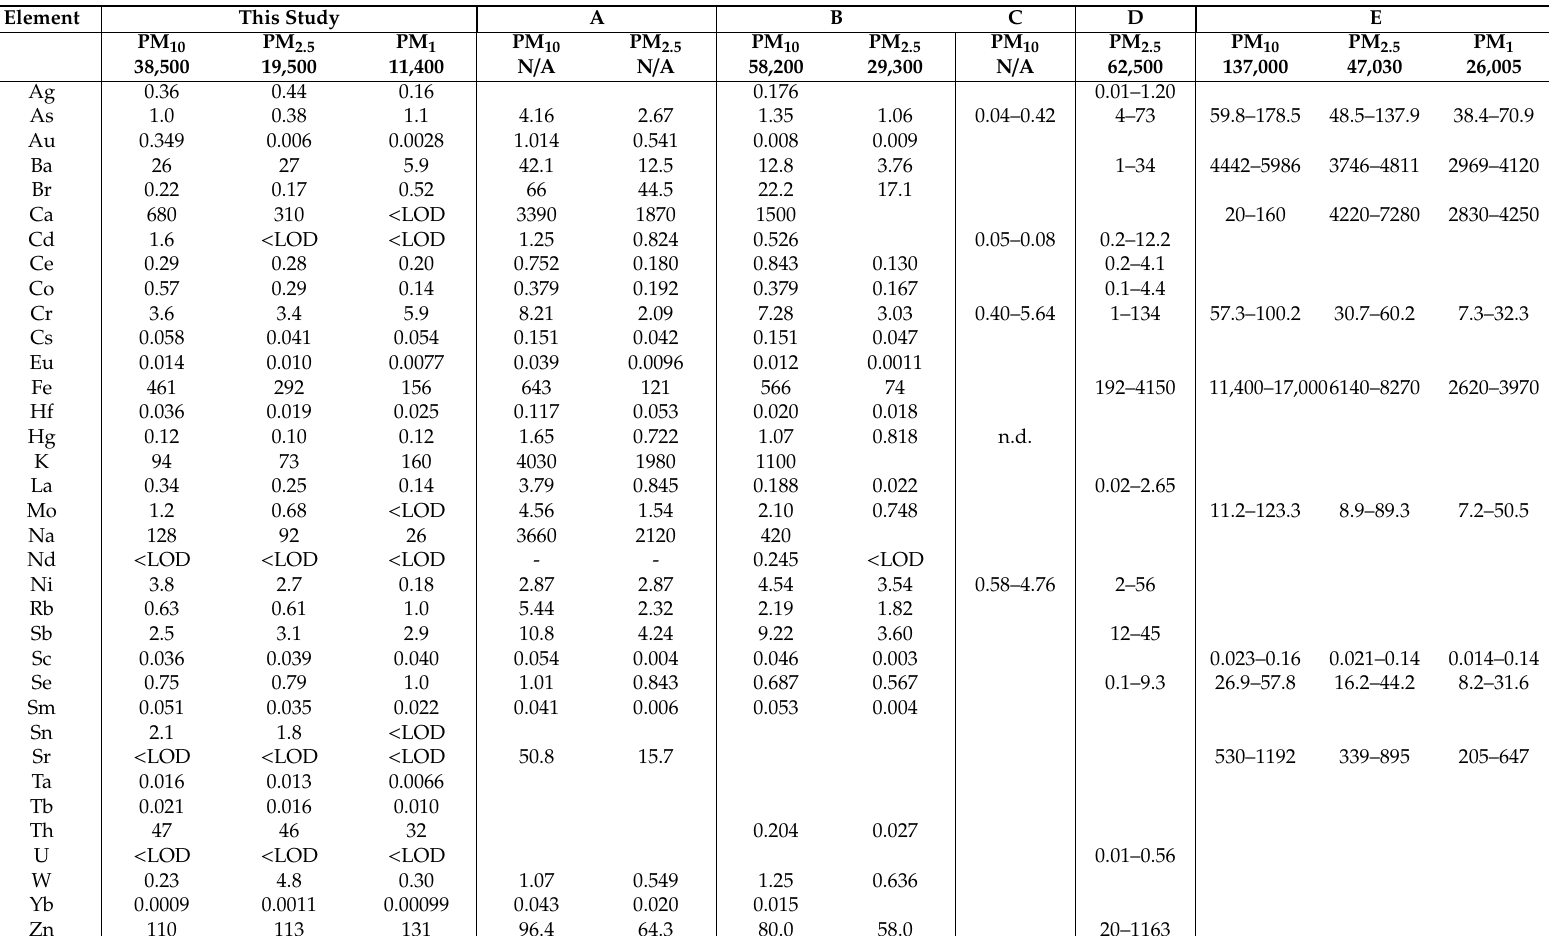
Table 5. Element concentrations (ng m − 3 ) in PM 10 , PM 2.5 , and PM 1 in comparison with other sites